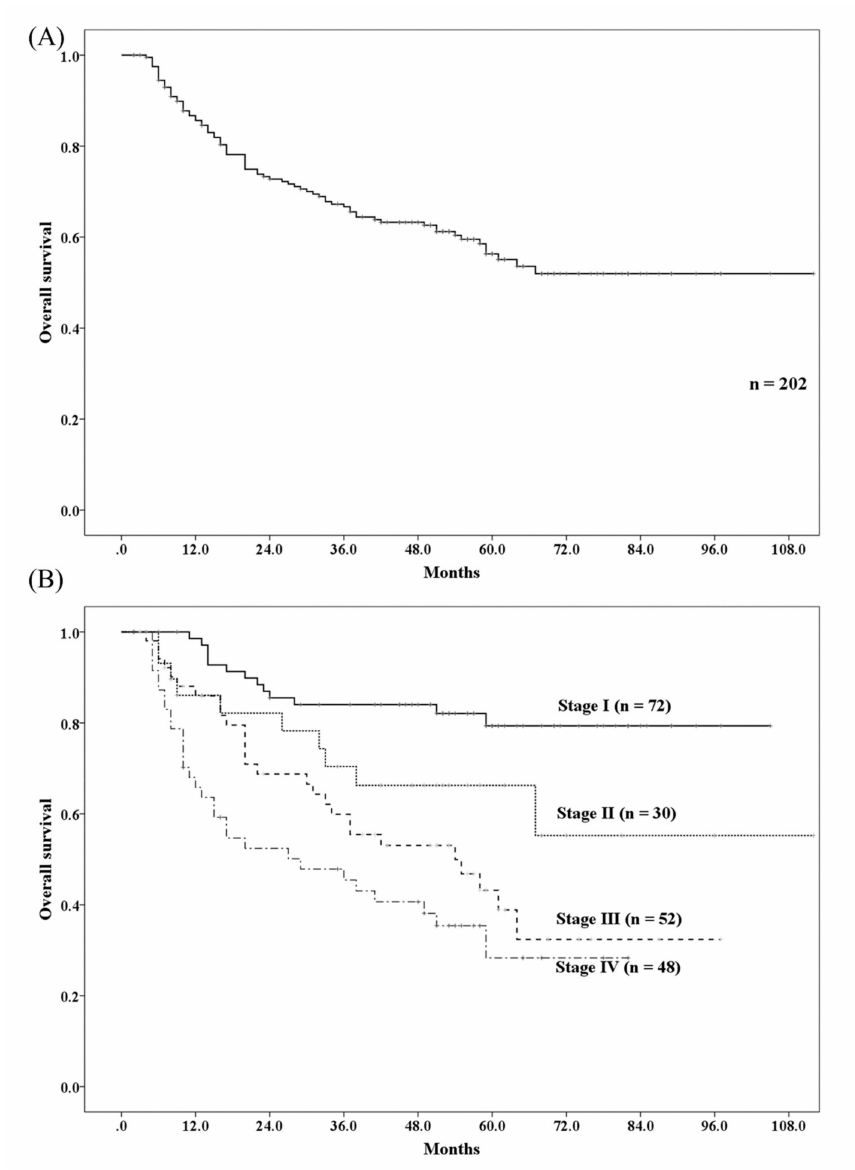
Figure 1. Overall survival rate of patients with esophageal cancer received proton beam therapy. ( A ) Overall survival rate for all patients. ( B ) Overall survival rate for each